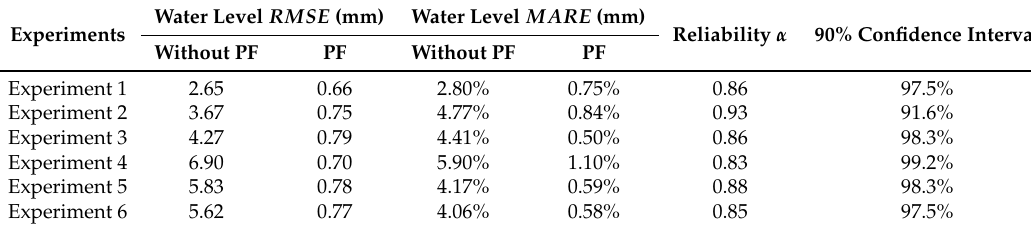
Table 1. Correction performance for different